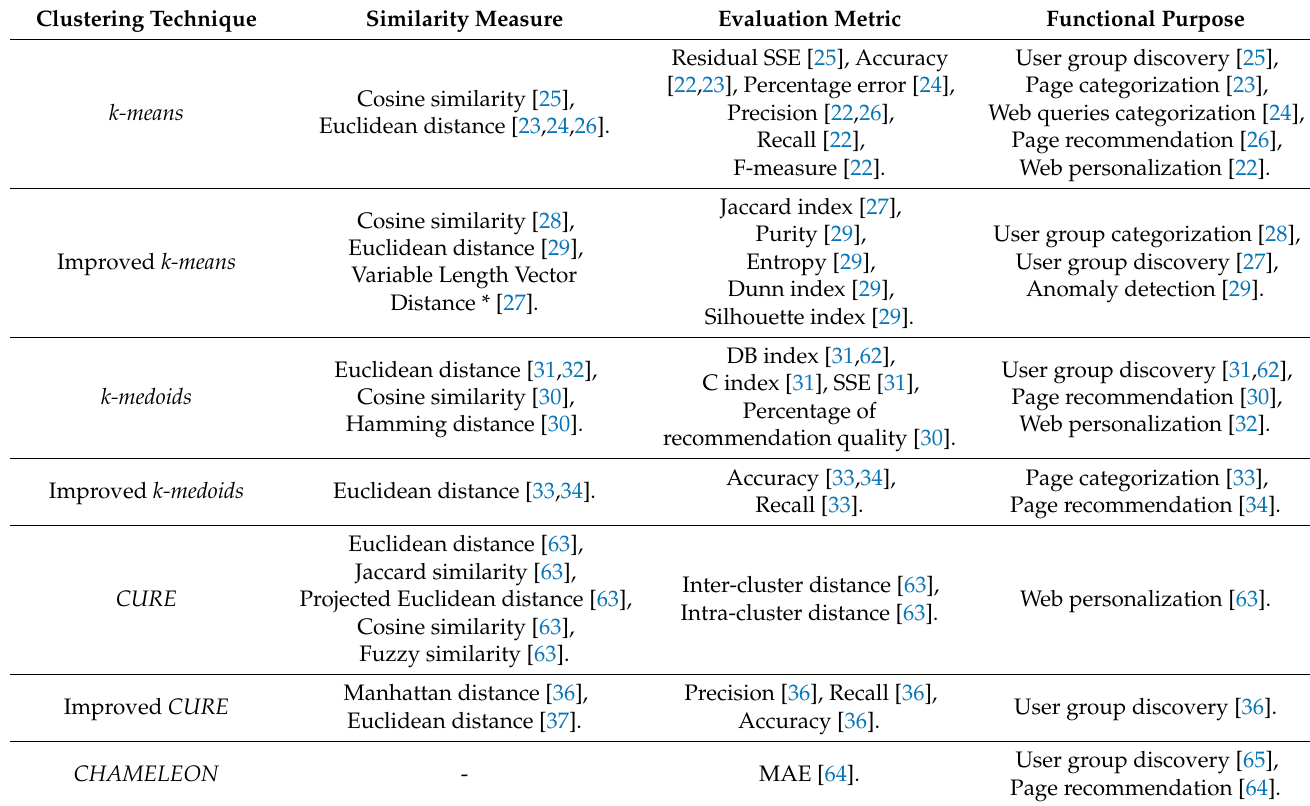
Table 1. The usage of clustering techniques in web usage